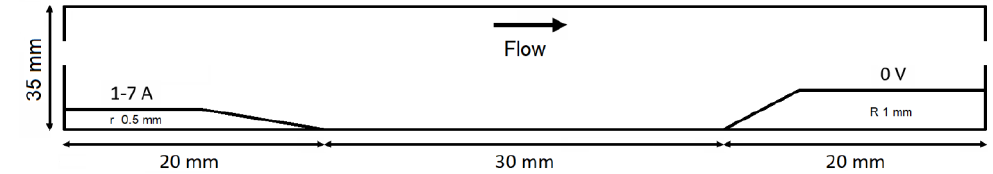
Figure 3. Geometry of electrode configuration for simulation in FlowVision and Plasmaero.